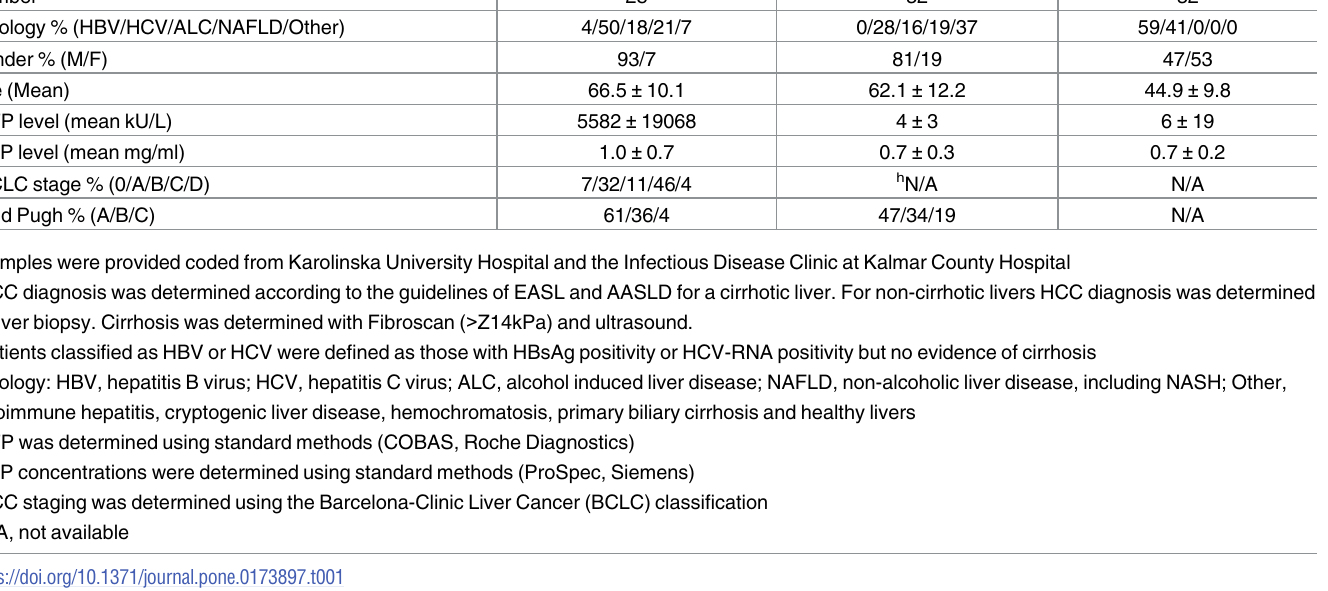
Table 1. Clinical featuresof patients used in the study. Disease diagnosis a